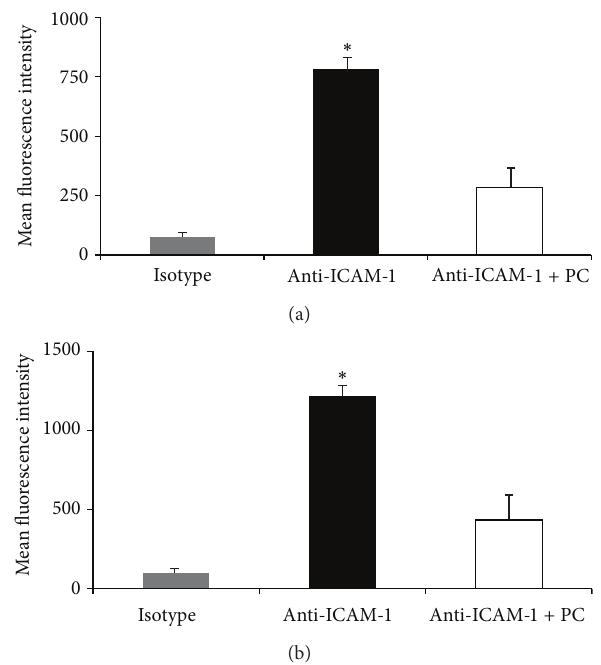
Figure 8: Effect of PC on endothelial ICAM-1 expression. Surface ICAM-1 expression was measured on freshly prepared (a) and TNF 𝛼 -stimulated(25 ngTNF 𝛼 /mL,4h)(b)endothelial cellswith or without PC preincubation (5U/10 6 leukocytes, 3 h) and compared to respective isotype controls. Mean fluorescence intensities are presented as mean ± SEM from at least three mice per group. Significant differences ( 𝑃 < 0.05 ) to isotype and anti-ICAM- 1 + PC are indicated by the